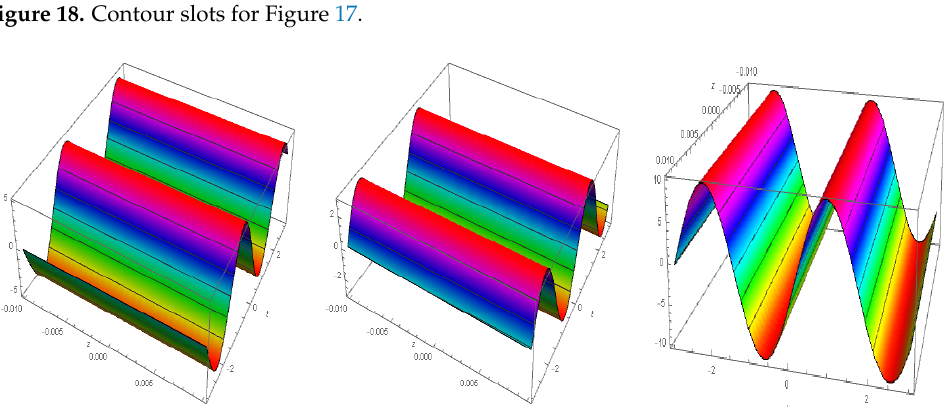
Figure 19. The HB profiles of the solution ∆ 11 in Equation (43) are constructed for values of c 1 = 2, c 2 = 1, k 1 = 3, k 2 = 0.1, γ = 1 and β = 5. Three-dimensional graphs at (i) d 3 = − 5, (ii) d 3 = 3 and (iii) d 3 =